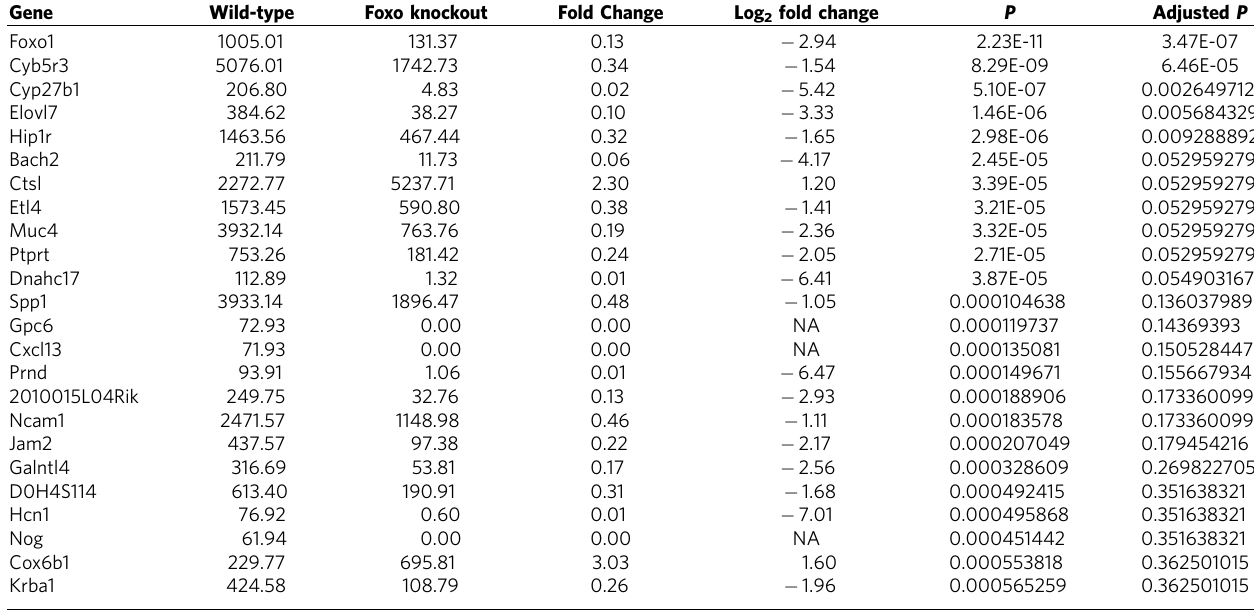
NA, not applicable. This table lists a subset of genes differentially expressed between wild-type and triple Foxo-deficient ALDH þ cells, arranged by P